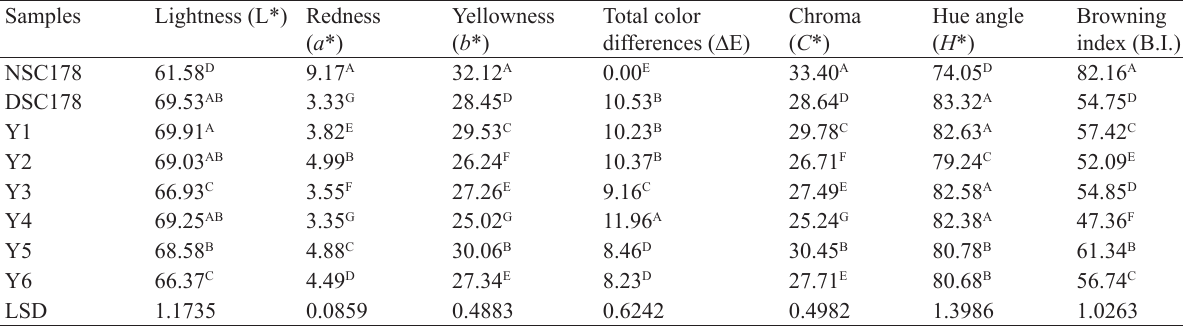
Table 3 Color attributes of snacks from drought-tolerant corn genotypes Samples